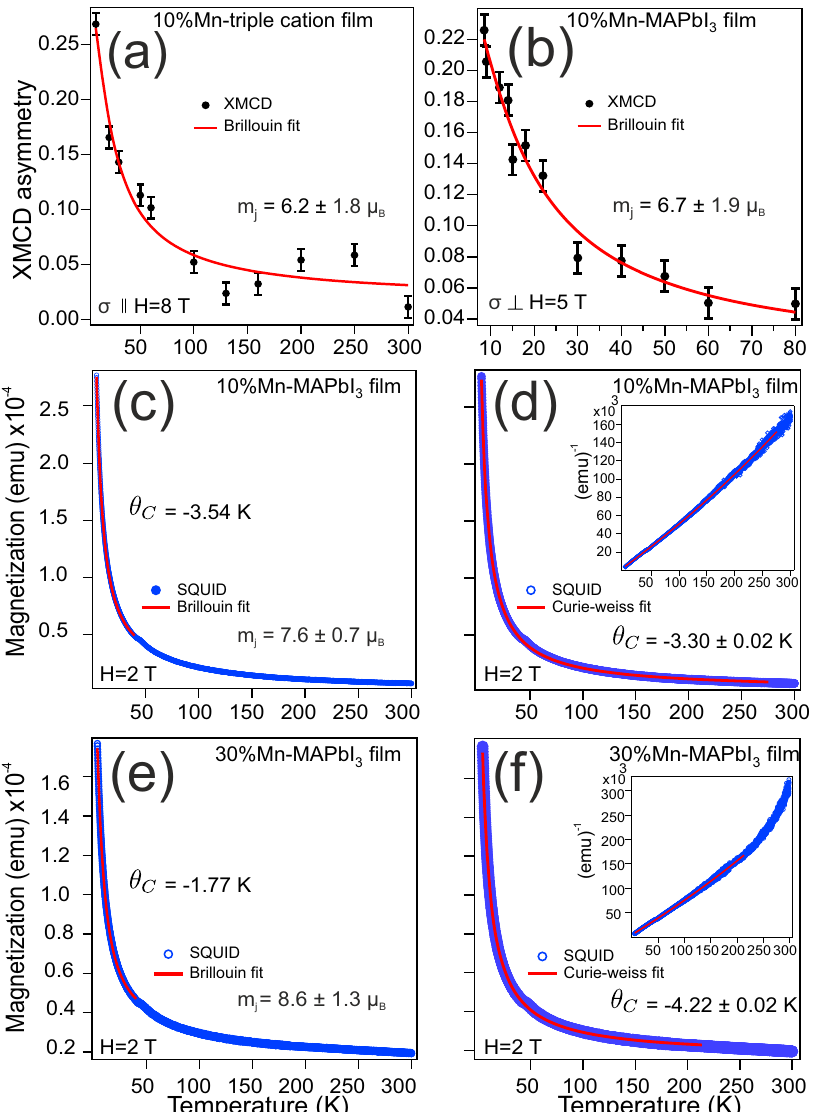
Fig. 5 Temperature evolution of X-ray magnetic circular dichroism (XMCD) asymmetry peak intensity from the Mn L 3 edge and magnetization from superconducting quantum interference device (SQUID). Temperature dependence of XMCD under the fi eld of 8 T for a parallel and b perpendicular to the surface, along with their Brillouin function fi ts (solid red lines). c – f Magnetization from SQUID of fi lms plotted as a function of temperature while heating recorded under an applied fi eld of 2 T parallel to the surface. Temperature-dependent components have been fi tted by both modi fi ed Brillouin ( c , e ) and the Curie – Weiss functions ( d , f ). Solid red lines in the insets of ( d , f ) represent the Curie – Weiss fi t the inverse magnetization in the low-temperature regime, where the diamagnetic portion of the signal has been subtracted prior to the fi